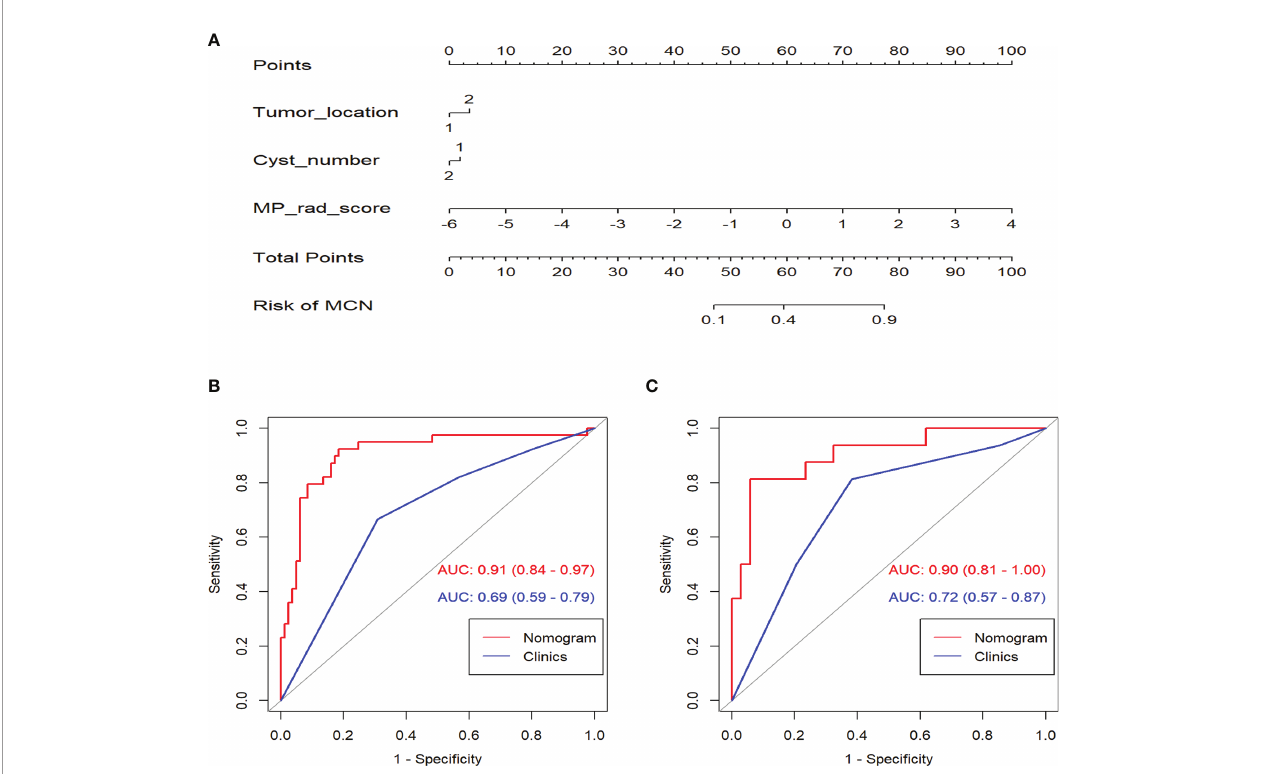
FIGURE 5 | (A) The nomogram established for the combined model. ROC curves comparison between the nomogram and clinical model in the training (B) and validation cohorts (C)